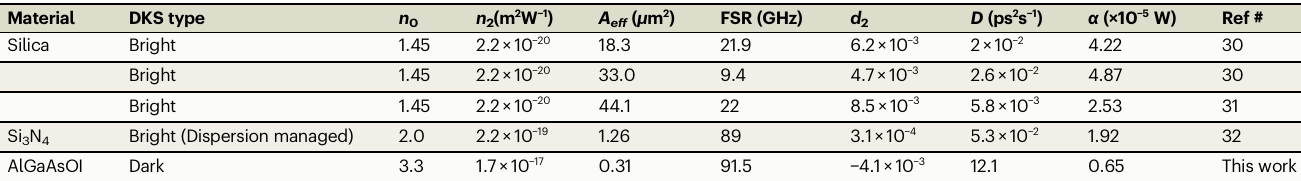
Table 1 | Experimental results on quantum decoherence of DKSs